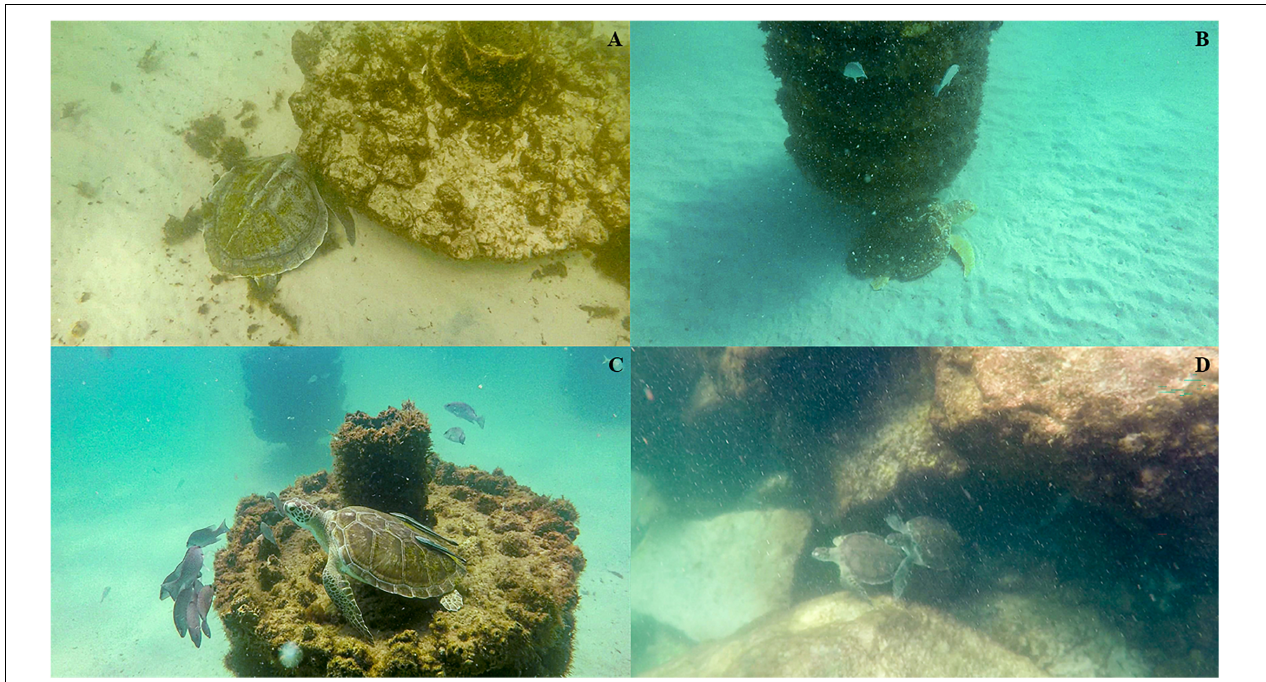
FIGURE 3 | All species of sea turtles using artificial habitats for resting and protection in the northeastern Gulf of Mexico. (A) Kemp’s ridley ( Lepidochelys kempii ), (B) Loggerhead ( Caretta caretta ), (C) green ( Chelonia mydas ), observed sitting on top of reef module, and (D) two juvenile green turtles observed resting and swimming together at the Destin East Pass Jetties.